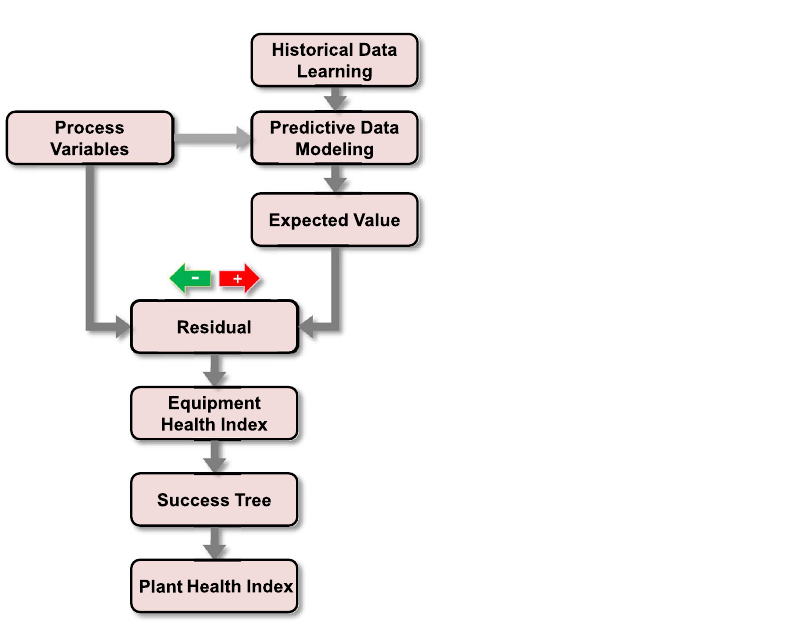
Figure 7. Procedure used in calculating the plant health index 19